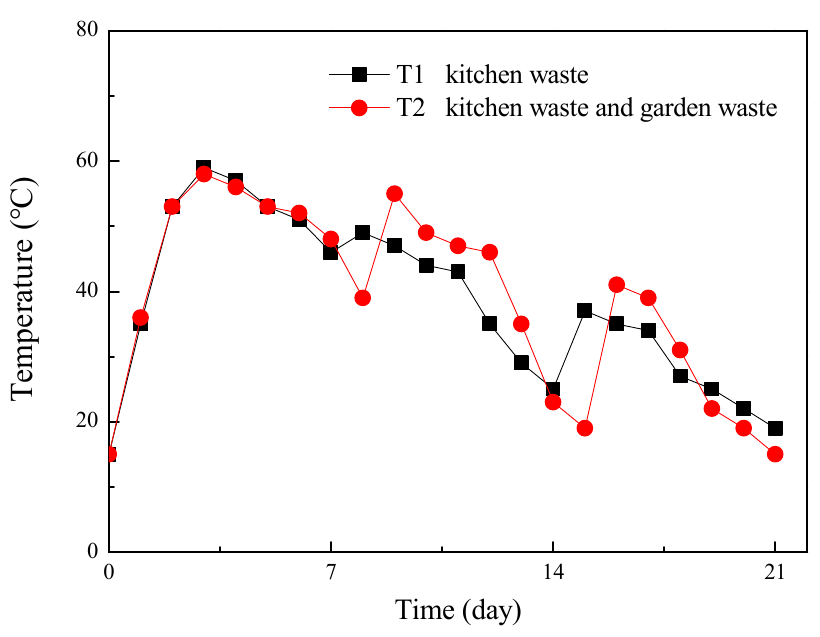
Figure 2. Evolution of temperature during composting.